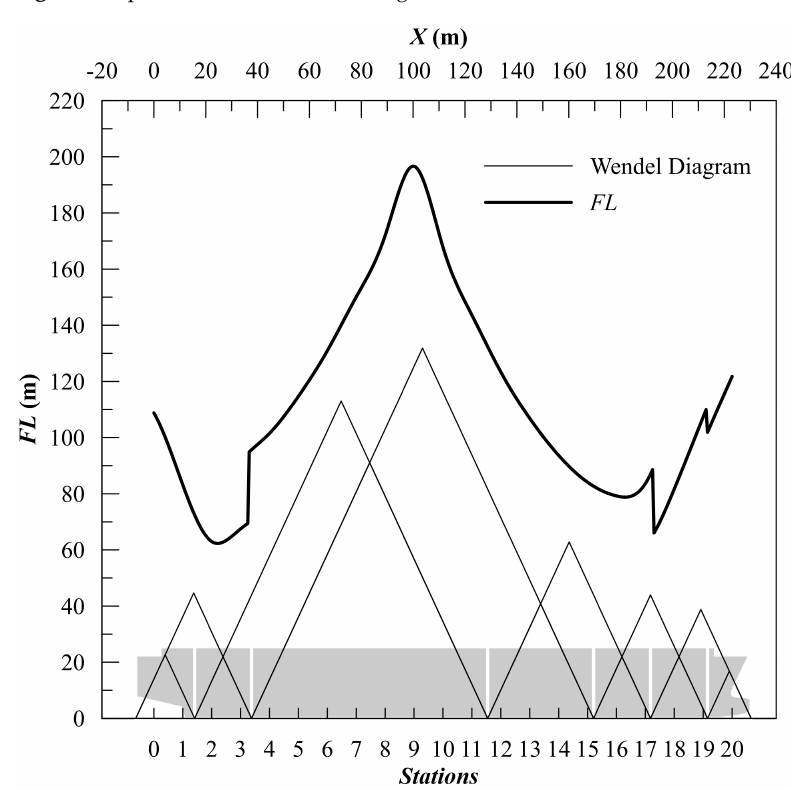
Figure 6. Optimised subdivision: 3 cargo hold